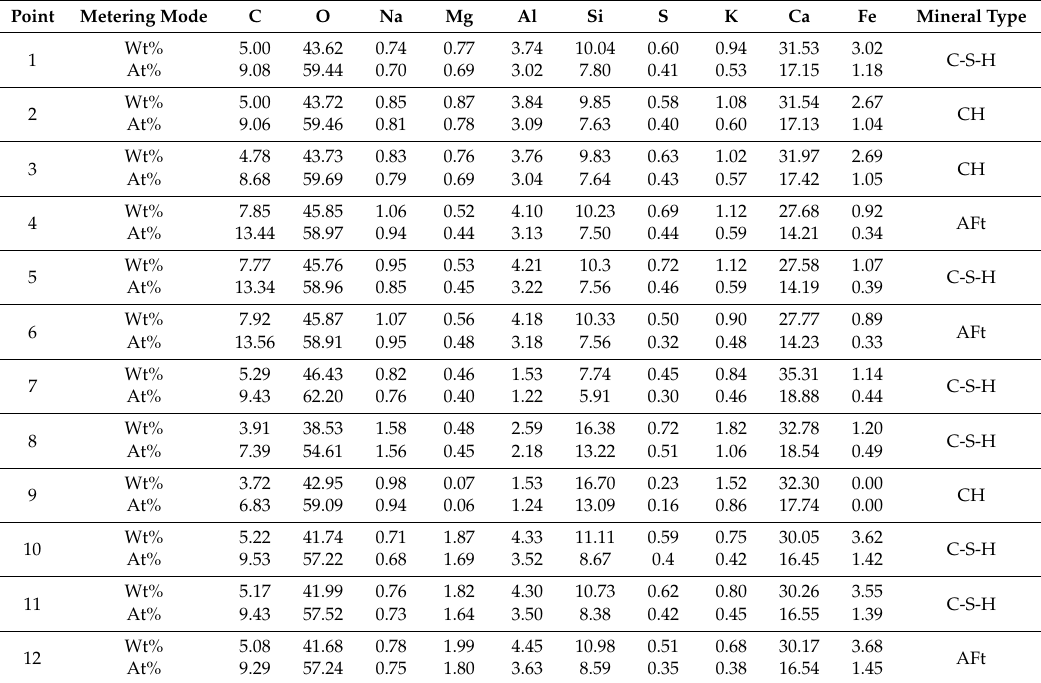
Table 6. Energy spectrum analysis results of MBER and